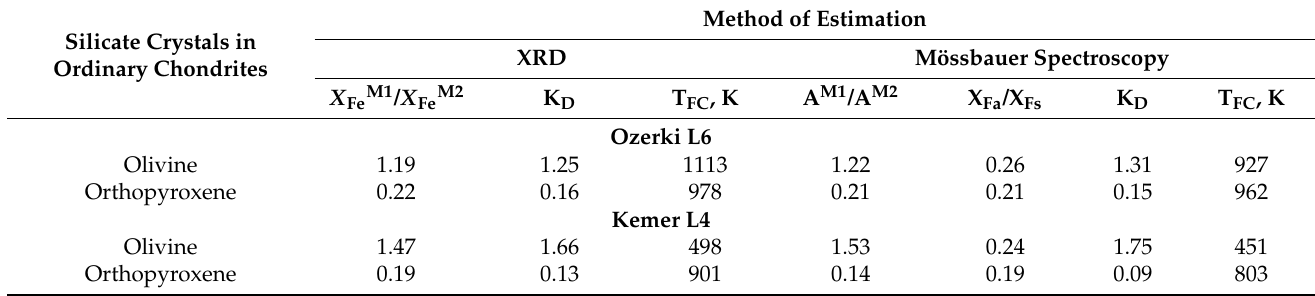
Table 4. The ratios of the Fe 2+ and Mg 2+ occupancies among the M1 and M2 sites and the values of the distribution coefficient and the temperature of silicate crystals in the fusion crust (before fast cooling) from ordinary chondrites determined by means of X-ray diffraction and Mössbauer spectroscopy (data were taken from References [99,100]). Silicate Crystals in Ordinary